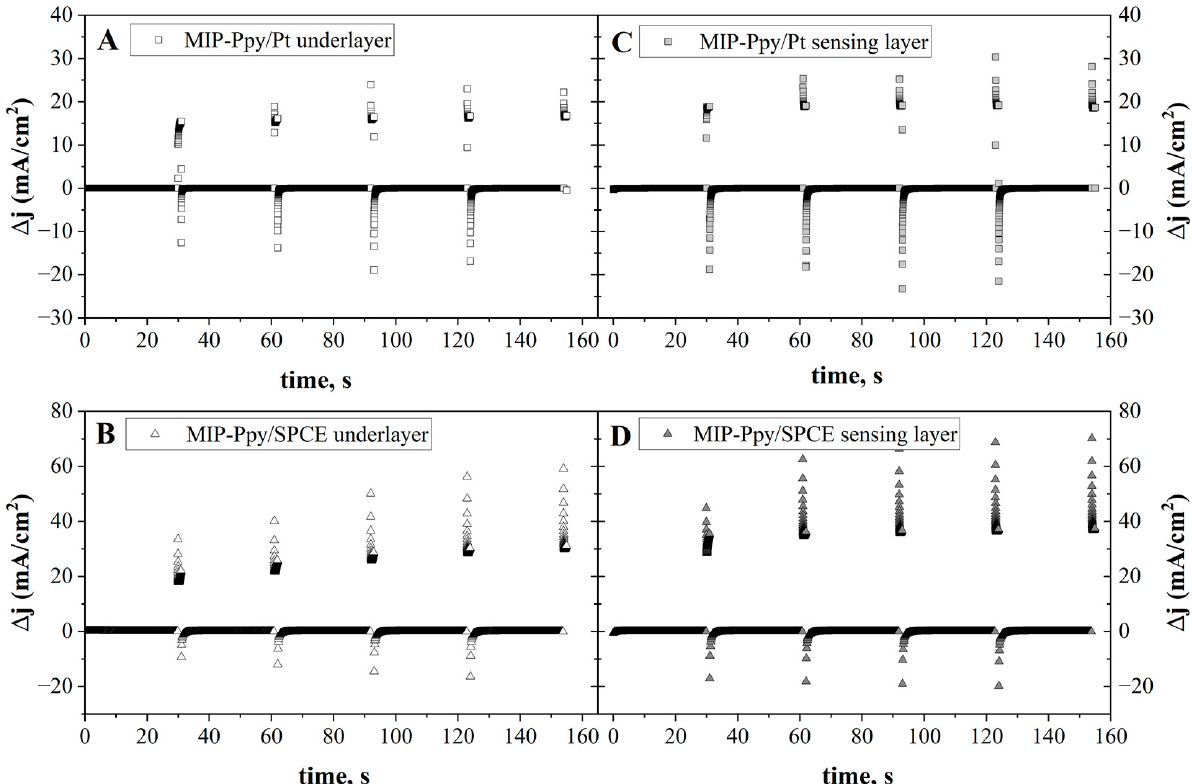
Figure 2. Current profiles registered during the deposition of Ppy underlayers ( A ) on Pt electrodes (second electrochemical system), and ( B ) on SPCE electrodes (first electrochemical system). Current profiles registered during electrochemical deposition of the polypyrrole layers with entrapped Listeria monocytogenes bacteria ( C ) on Pt electrodes (2nd electrochemical system), and ( D ) on SPCE electrodes (1st electrochemical system).